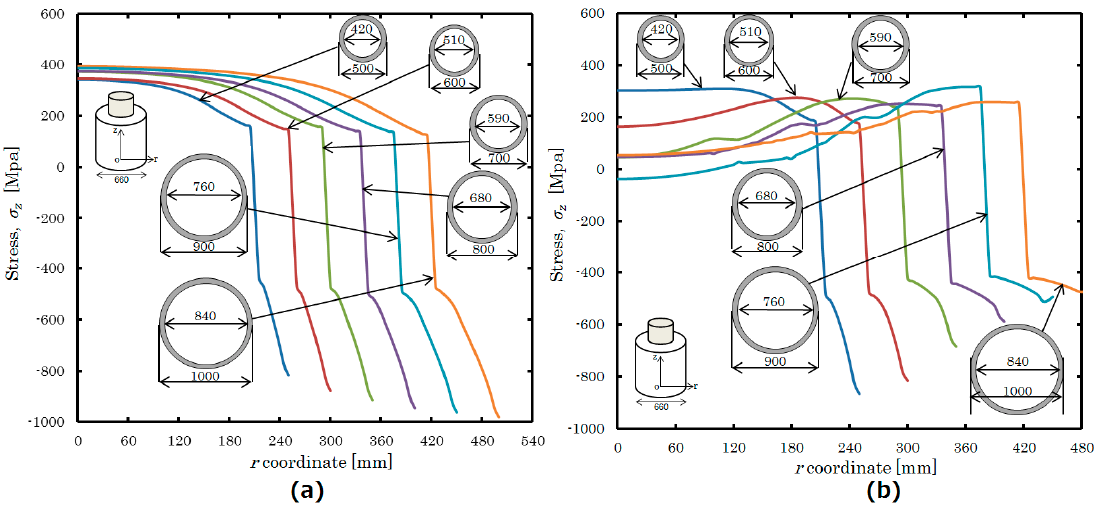
Figure 9. Residual stress distribution, σ z , for different diameters. ( a ) Uniform heating; ( b ) non- uniform heating.